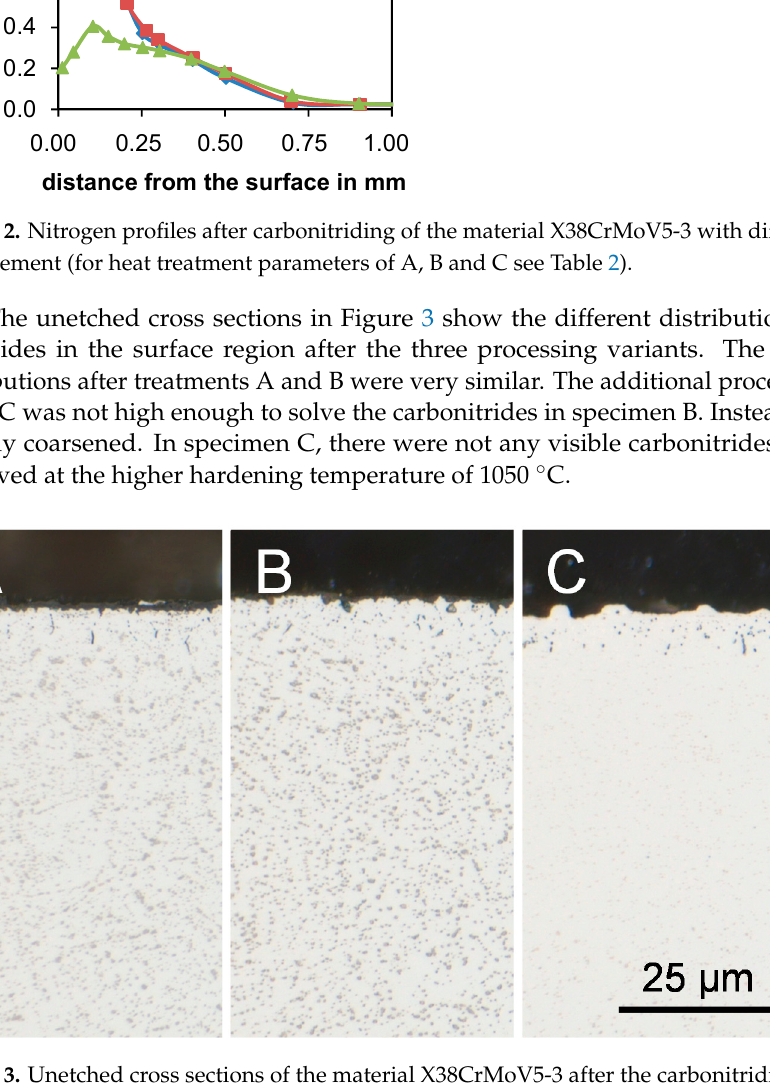
Figure 4. Cross sections of the material X38CrMoV5-3 after the carbonitriding treatments etched with Nital (for heat treatment parameters of ( A – C ) see Table 2). Due to the fact that nitrogen stabilizes the austenitic phase, retained austenite was expected in the surface region. Figure 5 shows the amount of retained austenite in the nitrogen-rich surface layer detected by X-ray diffraction. The treatment variant C had the highest amount of retained austenite at the surface, although the nitrogen content was significantly lower than the one of the two other treatments. This is due to the fact that the carbonitrides were dissolved during the hardening step at 1050 °C, and the nitrogen in the solution was higher than after treatments A and B where the most nitrogen was bonded in carbonitrides and therefore had no effect on the austenite stabilization.